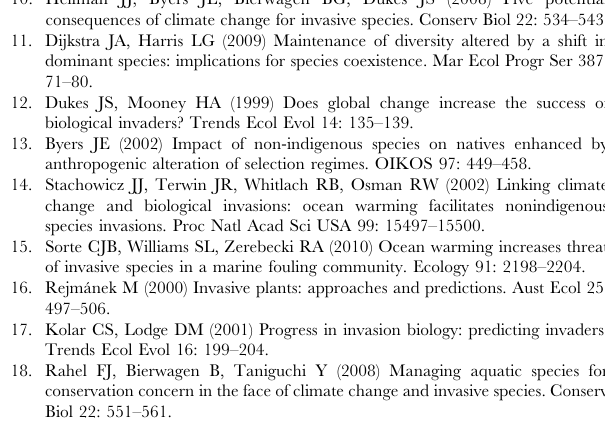
Figure S1 Mean ( 6 1 SE) mortality at 6 treatment temperatures between 14 and 31 degrees Celsius for each species (A, B. neritina; B, Watersipora; C, Botrylloides; D, Didemnum; E, Diplosoma; F, Botryllus; G, Distaplia; H, Ascidia; I, B. californica). LT50 after a 24 h exposure is denoted by the dashed